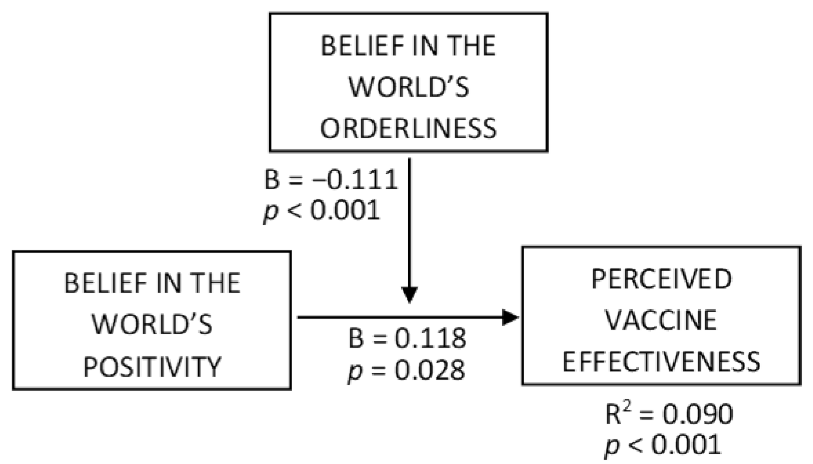
Figure 2. Moderation effects of belief in the world’s orderliness on the relationship between belief in the world’s positivity and perceived vaccine effectiveness.